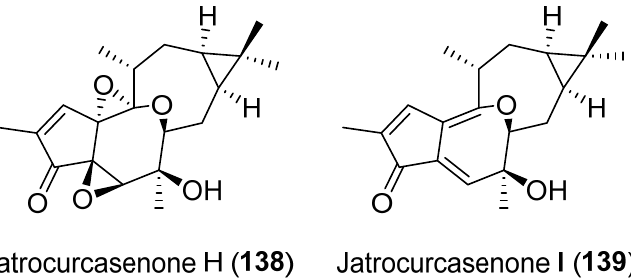
Figure 24. Structure of Jatrocurcasenones H and I.